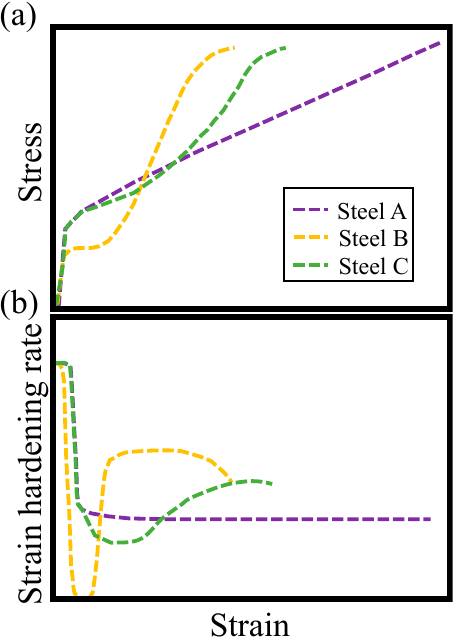
Figure 5. ( a ) Stress–strain curves and ( b ) strain hardening rate–strain curves corresponding to three different steels with a fully austenitic structure before the test starts and with the same austenite σ Y . Steel A is plastically deformed and no stress/strain induced transformation occurs and steels B and C undergo stress and strain transformations, respectively. Units are arbitrary.